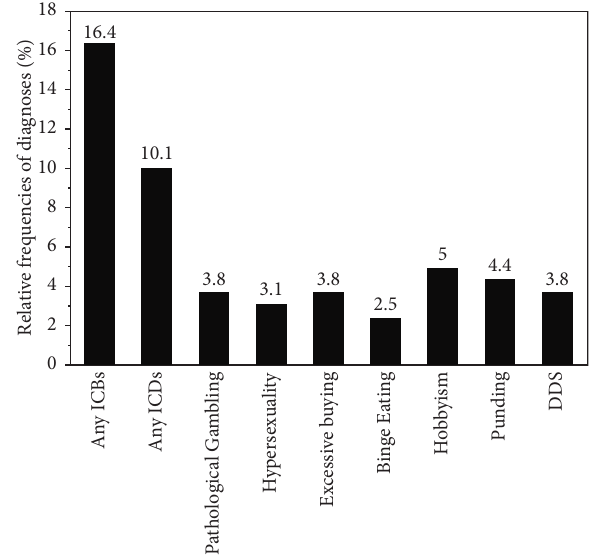
Figure 1: Relative frequencies of the impulsive-compulsive dis- orders (ICDs) by a semistructured interview. DDS, dopamine dysregulation syndrome; ICBs, impulsive-compulsive behaviors; ICDs, impulse control